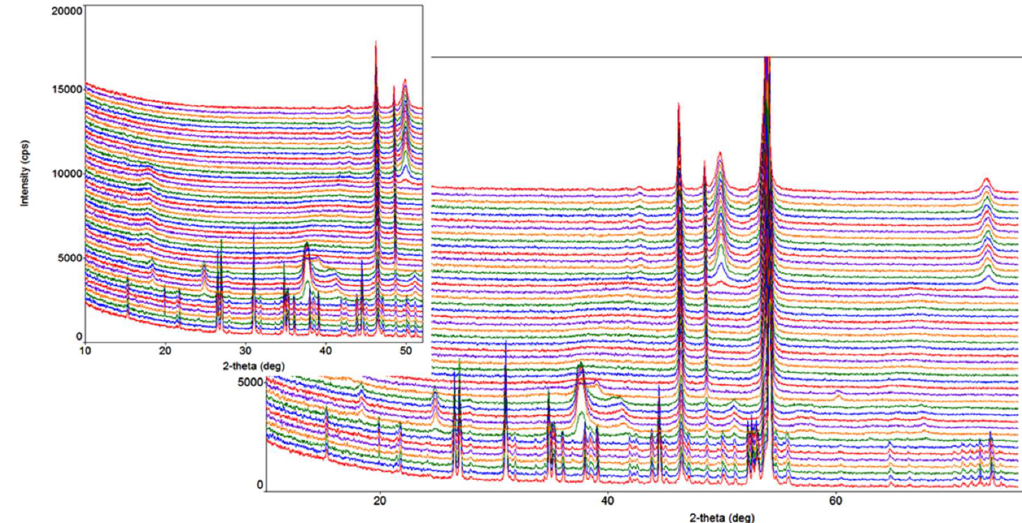
Figure 1. Powder X-ray diffraction pattern recorded for NH 4 MgCl 3 ·6H 2 O up to 540 °C.